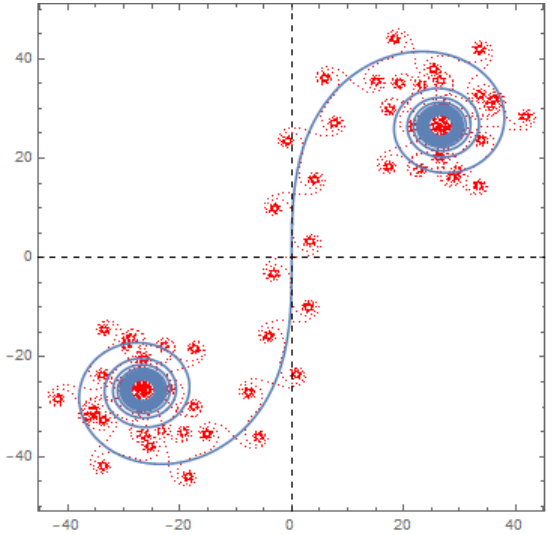
Figure 4. A striking manifestation of the self-similarity that can exist in these lacunary systems. The graphs shows the case of F 2831,67 . This is one of the two most ordered of the 67 canonical members of this family (the other is rotated by π /2). The full shape is composed of q = 67 individual Cornu spirals. Interestingly, the inflection points of each Cornu spiral falls along the blue curve which is precisely a rotated and inverted Cornu spiral of the F 2831,1 case. Furthermore, the individual Cornu spirals alternate as tangent or normal to the blue